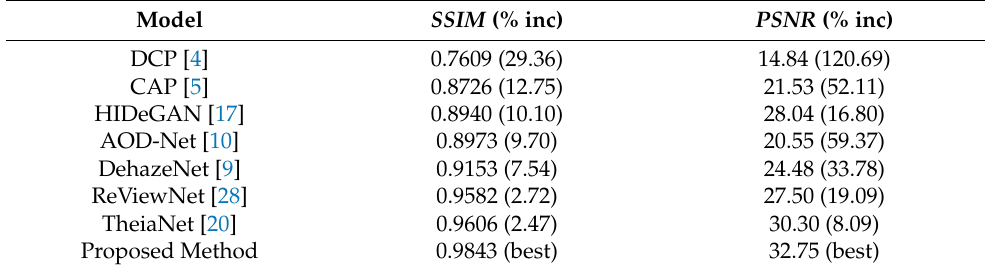
Table 7. Comparison of dehazing results on RESIDE HSTS dataset.